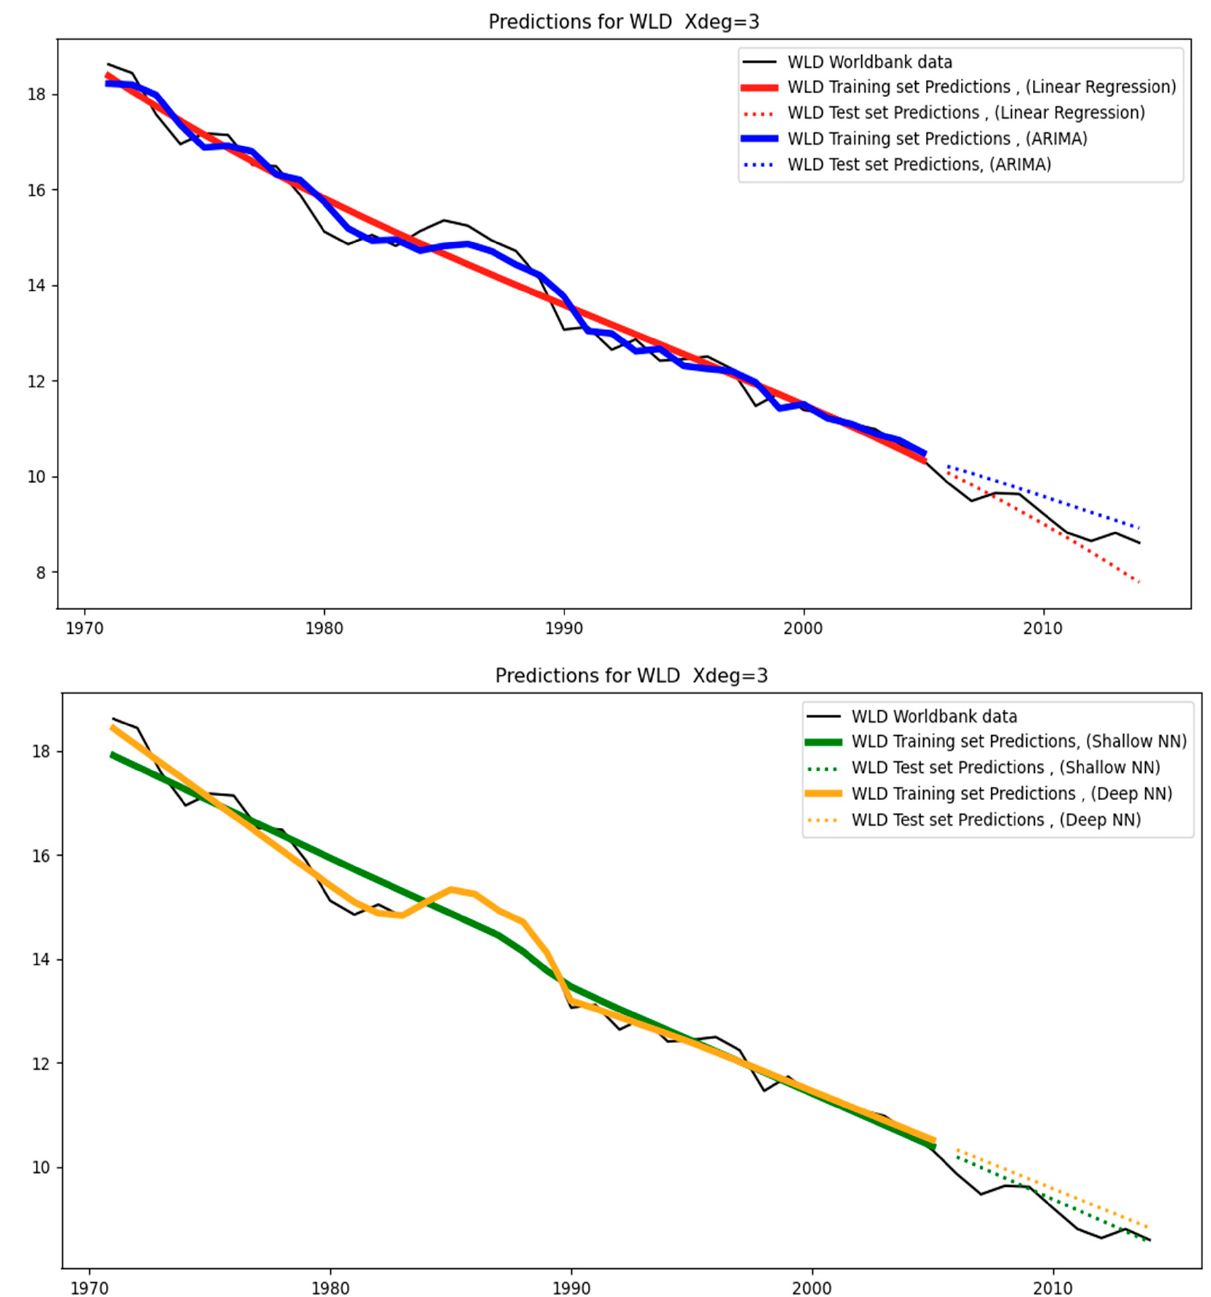
Figure 8. Predictions for the world average (WLD), with a third-degree polynomial (Xdeg = 3), are shown for both the training set (periods 1971–2005) and the test sets (periods 2006–2014), using linear regression (LR), ARIMA, shallow neural networks, and deep neural network models.